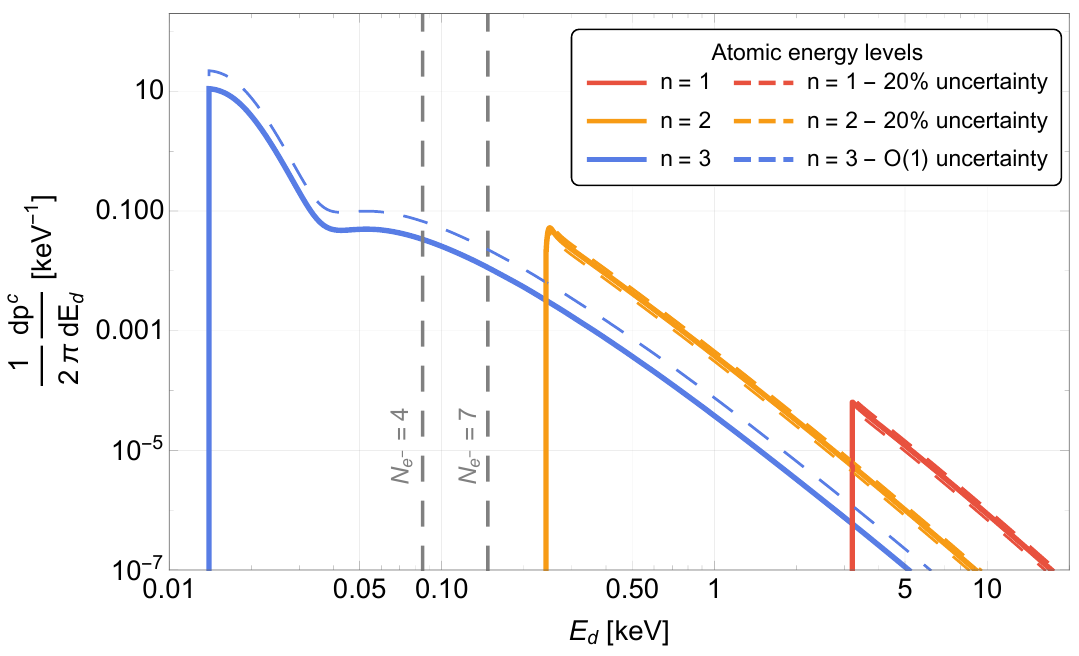
Figure 1 . Differential ionization probabilities and related uncertainties as a function of the detected energy E d for isolated argon and different principal quantum number n . We show also the 4 and 7 electron thresholds for